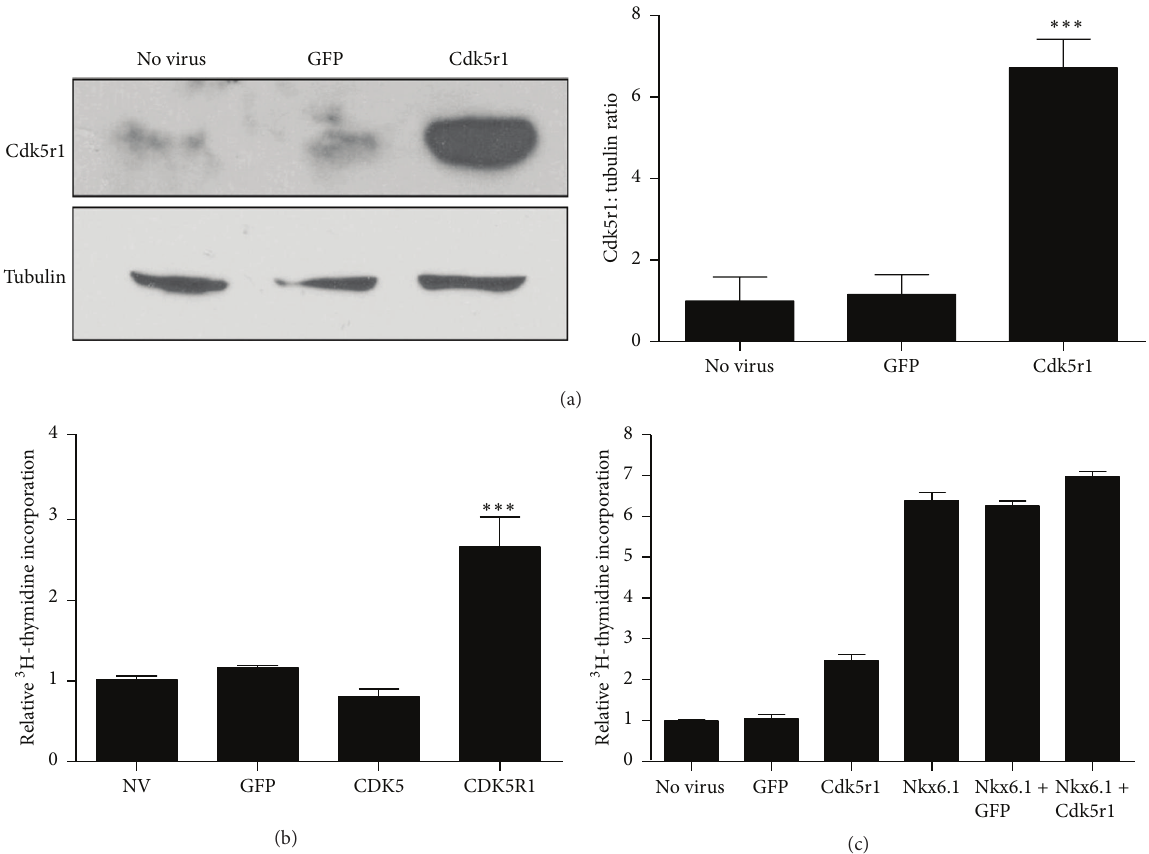
Figure 3: Overexpression of Cdk5r1 is sufficient to induce primary rat islet proliferation. (a) Islets were transduced with AdCMV-GFP or AdCMV-Cdk5r1. Protein was harvested 96 hours after viral transduction. A 6-fold increase was observed in Cdk5r1 protein levels in islets transduced with AdCMV-Cdk5r1, as compared to the observed low endogenous level in primary rat islets. Data represent the mean ± SEM of six independent experiments representing the comparison between untreated islets and islets transduced with AdCMV-Cdk5r1. (b) Incorporation of [ 3 H-methyl]-thymidine in rat islets. Rat islets transduced with AdCMV-Cdk5r1 have increased proliferation, while islets treated with AdCMV-GFP or AdCMV-Cdk5 have no induction of proliferation. Data represent the mean ± SEM of four independent experiments representing the comparison between untreated islets and islets transduced with AdCMV-Cdk5r1. (c) Islets were transduced with AdCMV-GFP, Cdk5r1, or Nkx6.1 or were transduced with AdCMV-Nkx6.1 and either GFP or Cdk5r1. Islets were labeled with 3 H- thymidine 72 hours after viral transduction, followed by measurements of proliferation at 96 hours after viral transduction. Data represent the mean ± SEM of four independent experiments representing the comparison between AdCMV-Nkx6.1 treated islets and islets cotransduced with AdCMV-Nkx6.1 and AdCMV-Cdk5r1. ∗ 𝑝 ≤ 0.05 ; ∗∗∗ 𝑝 ≤ 0.001